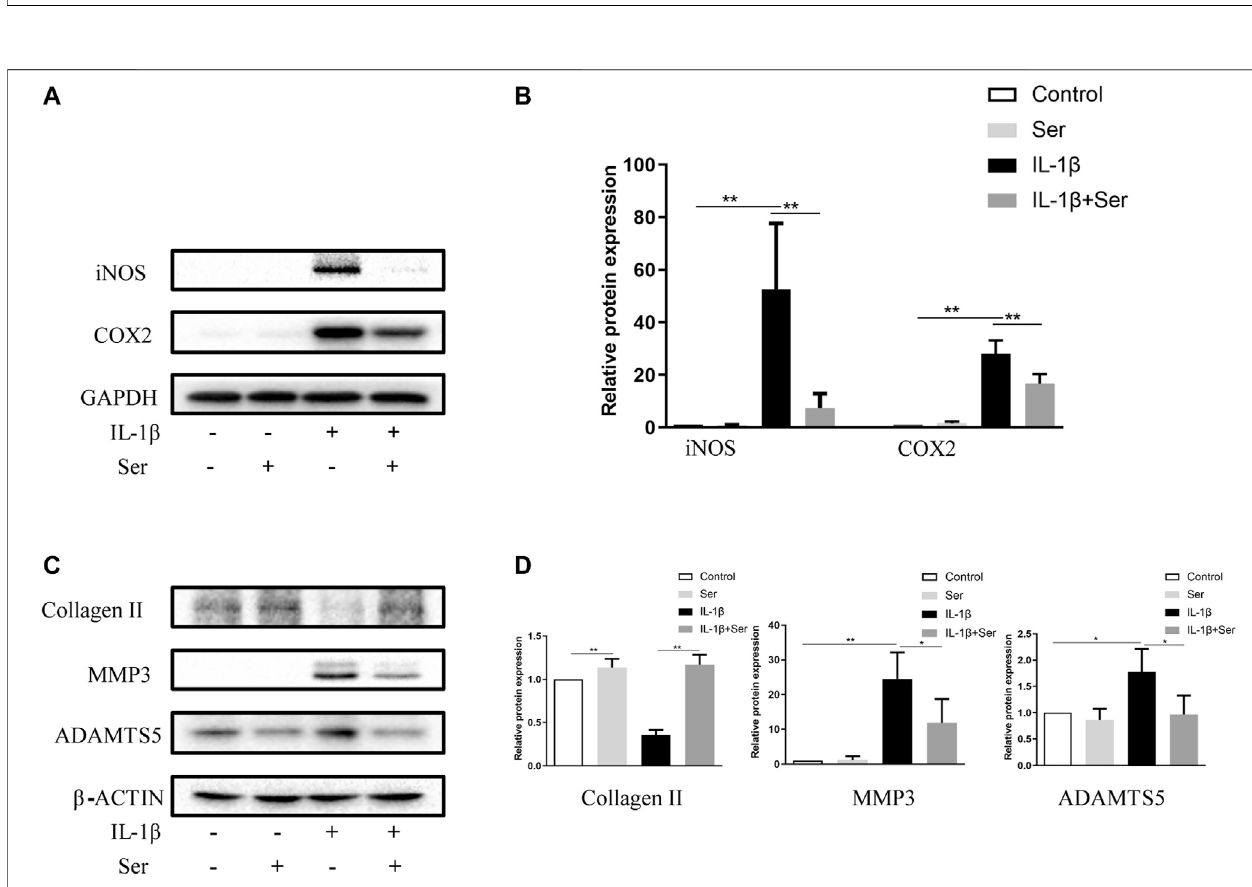
Frontiers in Pharmacology |